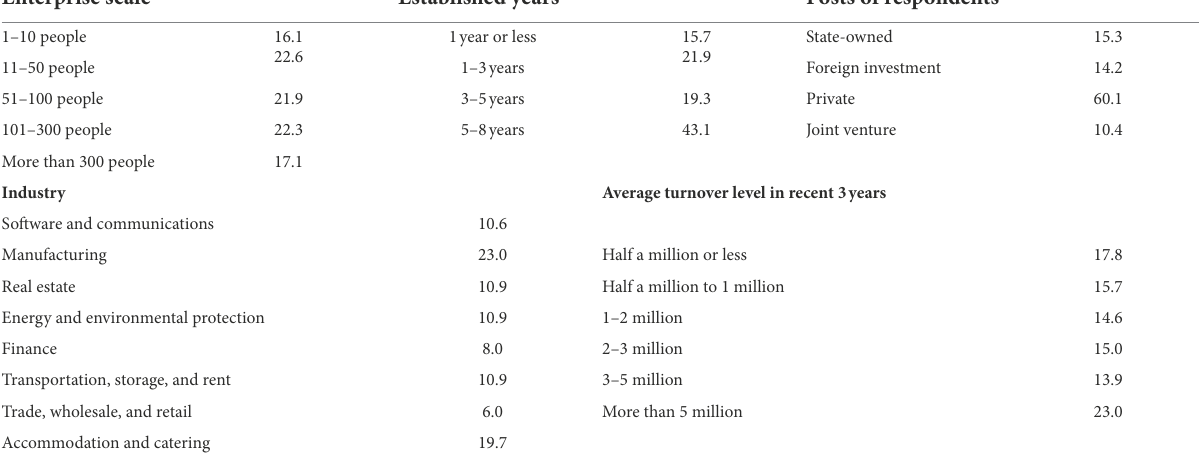
TABLE 1 Characteristics of survey